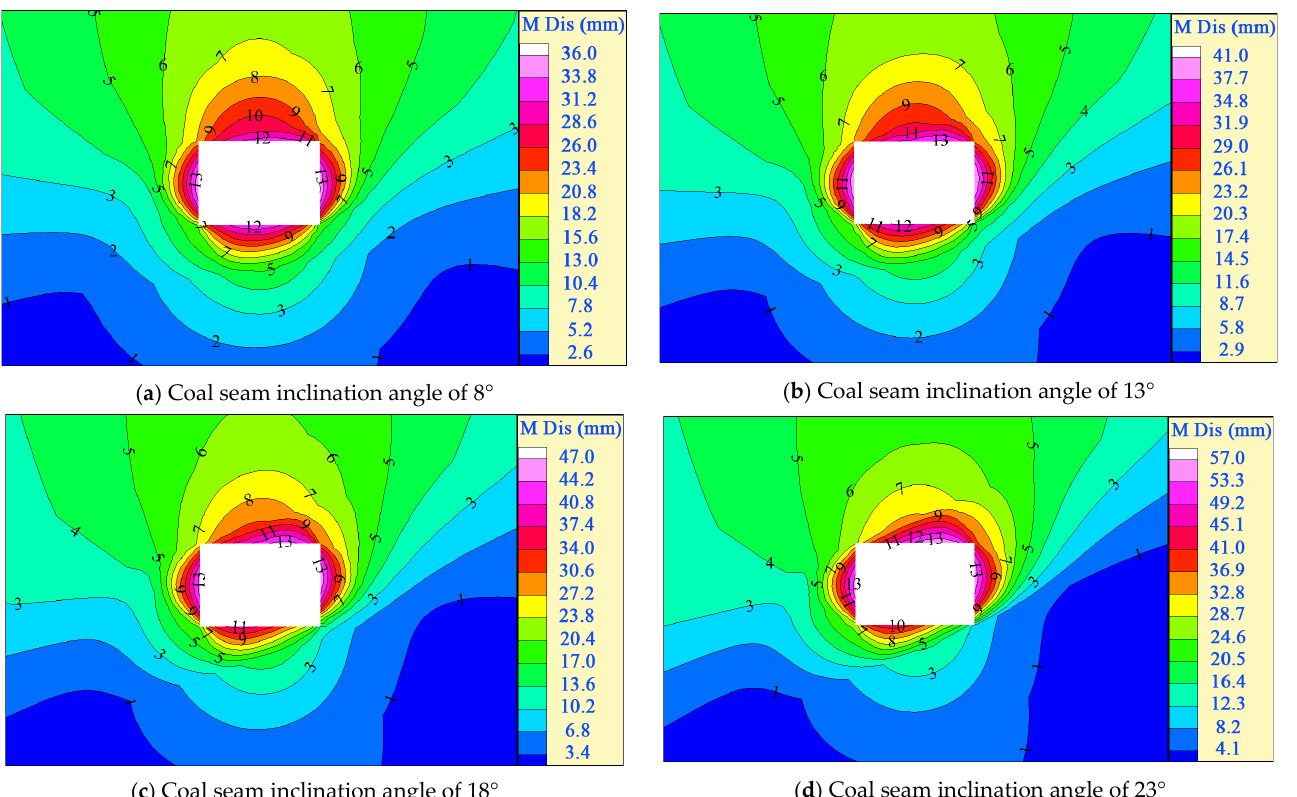
Figure 12. Development of excavated plastic area of the roadway with different inclination angles.